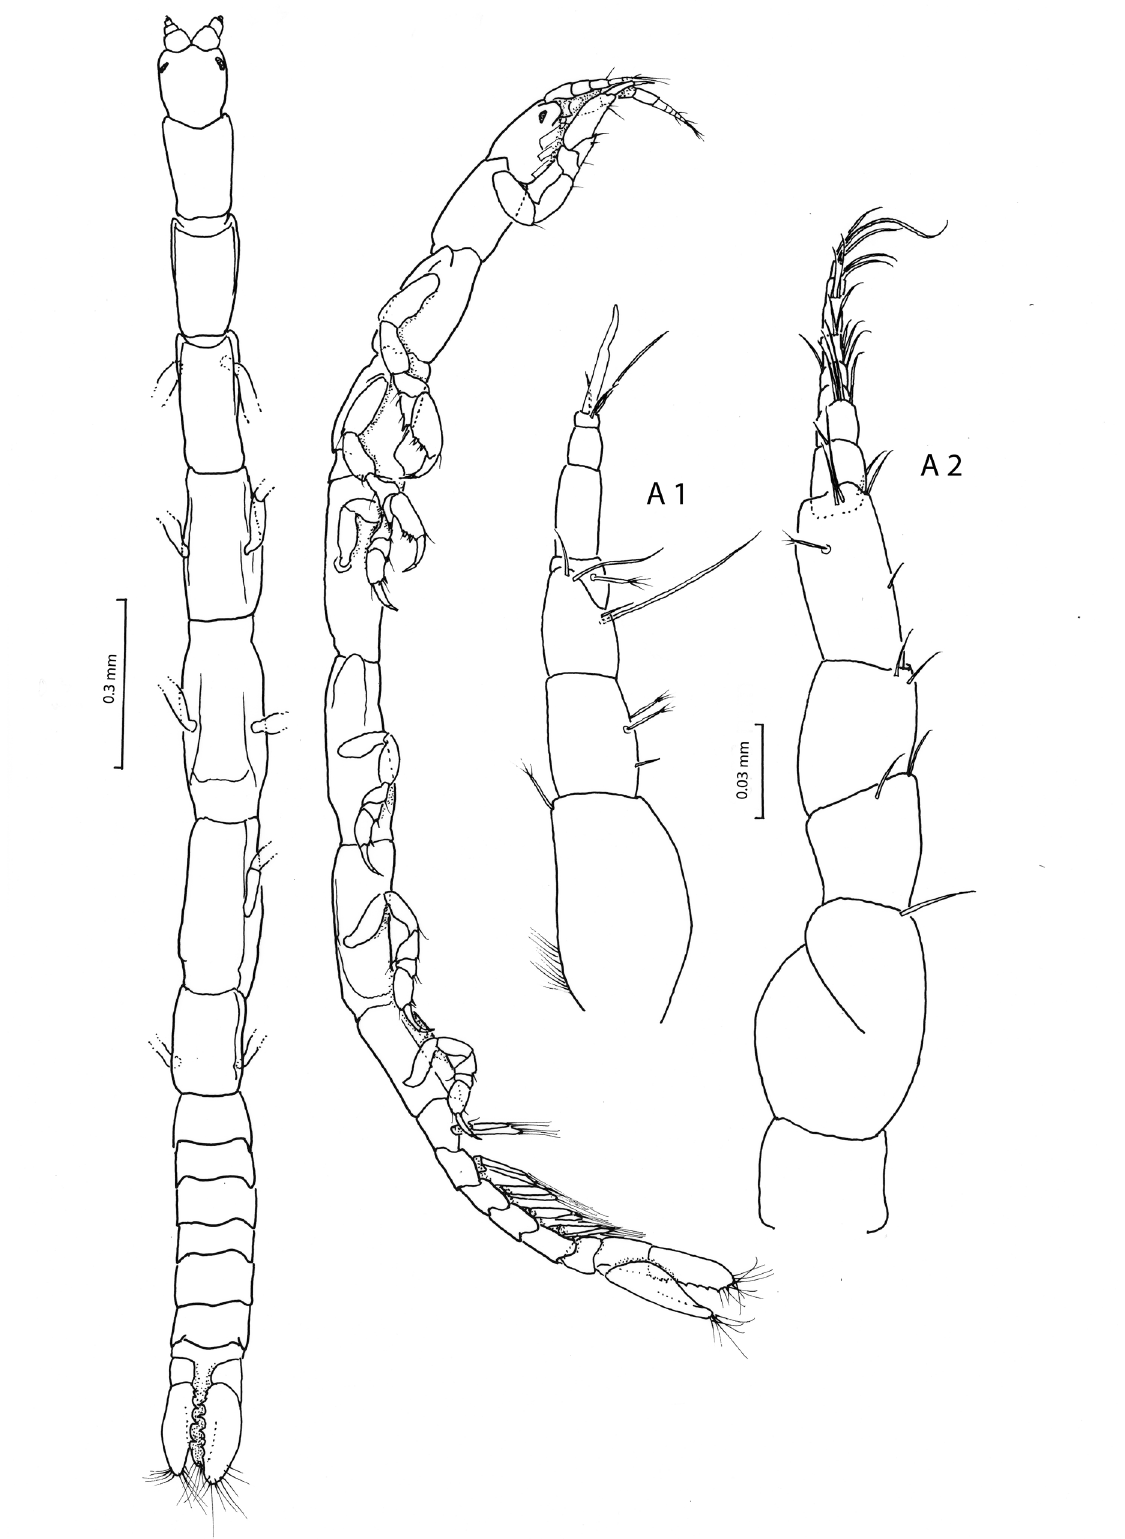
Fig. 10. Kupellonura macaroni sp. nov ., holotype, immature adult, in dorsal and lateral view (3.2 mm) (MZB Iso 102). Abbreviations: A1 = antenna 1, A2 = antenna